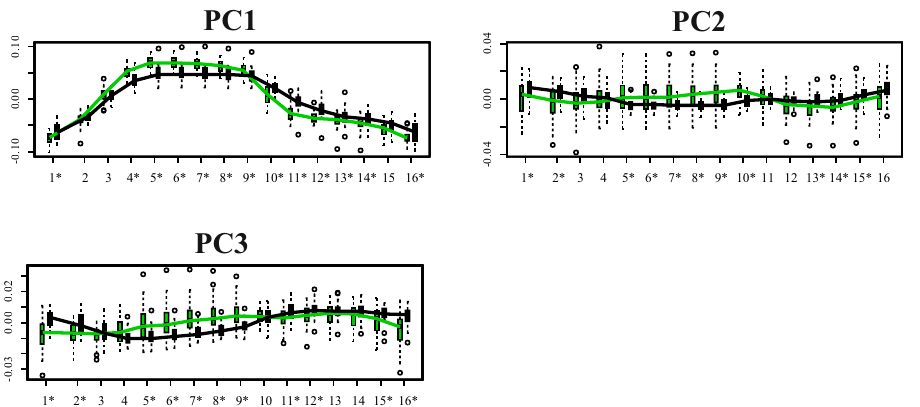
Figure 3. Distribution of the first three PC scores among Control (green) and HCM (black). Boxplots relative to Control and HCM are displayed at all homologous times. Asterisks indicate significance under ANOVA. As it can been seen, even the diastolic state significantly differs between the two categories.